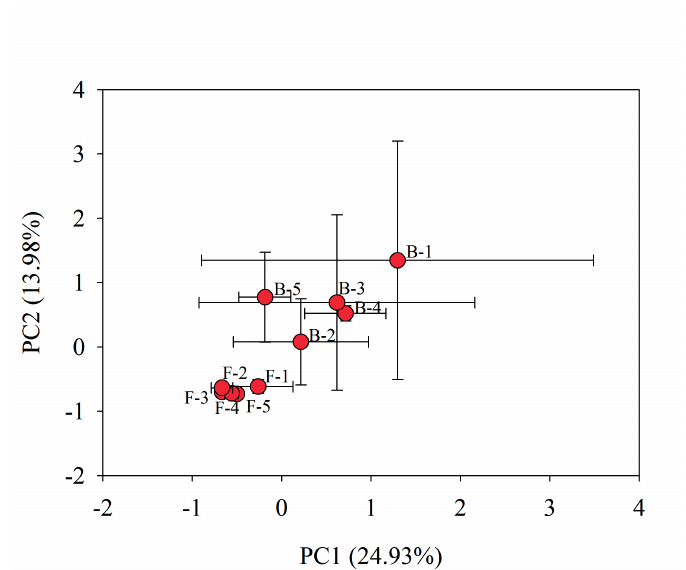
Figure 4. Principal components analysis (PCA) of 31 different sole carbon